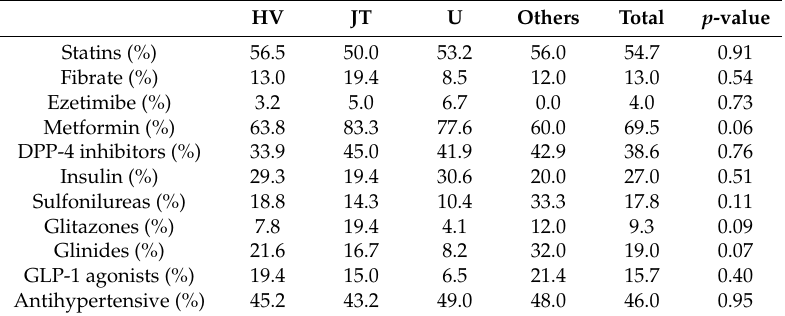
Table 2. Pharmacological treatment of the study’s cohort of type 2 diabetic patients. HV JT U Others Total p